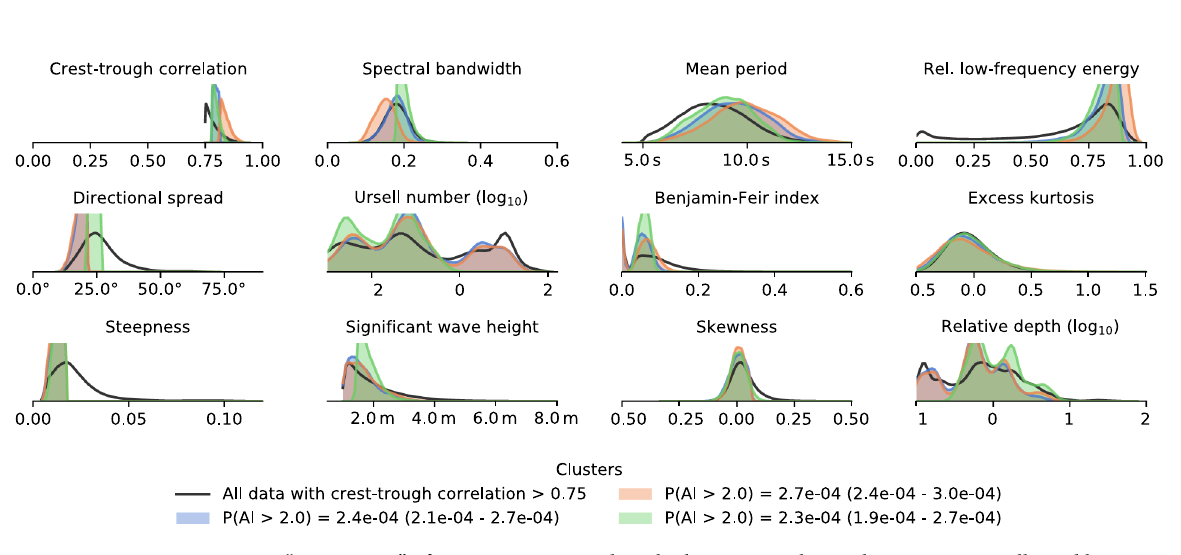
Figure 2. “Hot corners” of rogue wave activity have high crest-trough correlation, strong swells, and low steepness. Shown is the distribution of each cluster population in parameter space, and the distribution of all waves with high crest-trough correlation for comparison. Clusters are computed through decision-tree based clustering (see “Methods”), taking all parameters into account at the same time. All clusters show a higher rogue wave incidence than any univariate bin. Ranges in legend indicate 95% credible